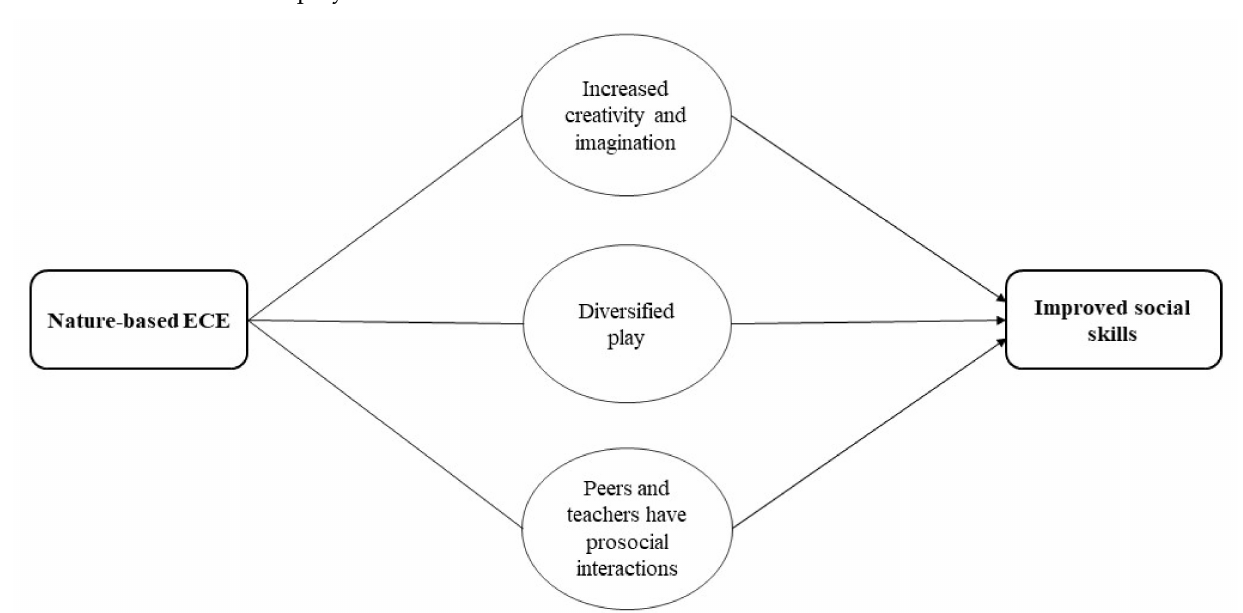
Figure 7. Convergent synthesis on how nature-based ECE could influence social skills. An arrow denotes where factors lead to an influence on social skills.